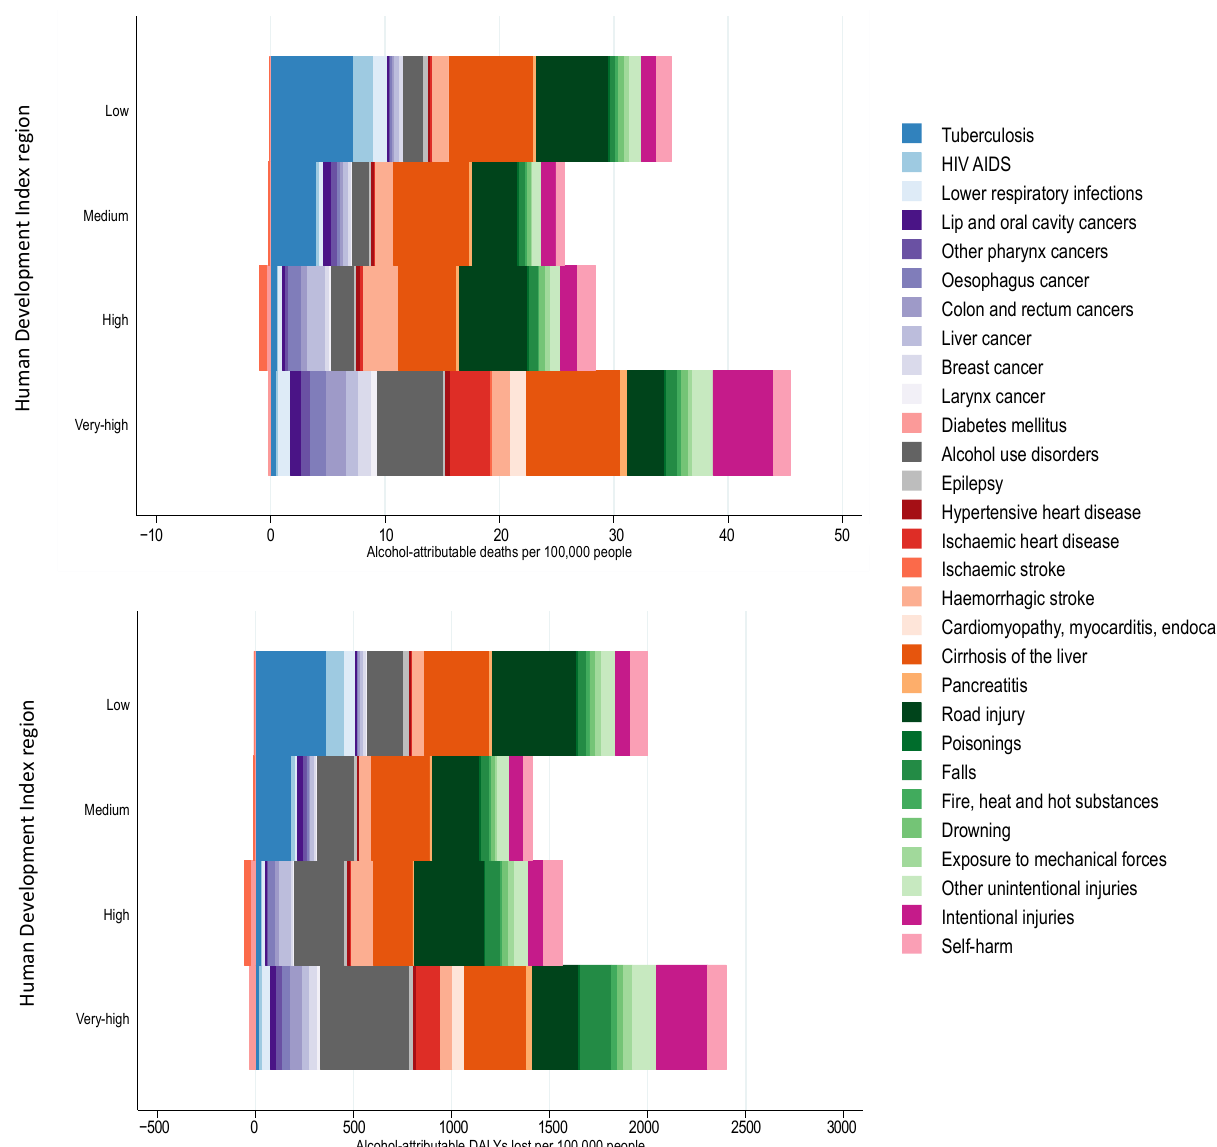
Figure 4. Alcohol-attributable deaths and disability adjusted life years (DALYs) lost among people 0 to 70 years of age by human development index region.